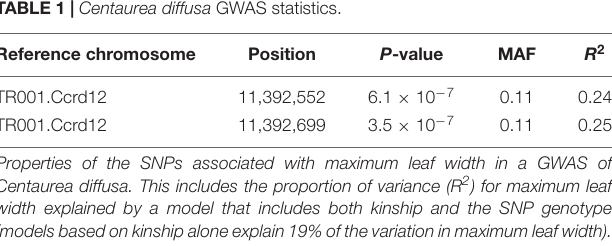
TABLE 1 | Centaurea diffusa GWAS